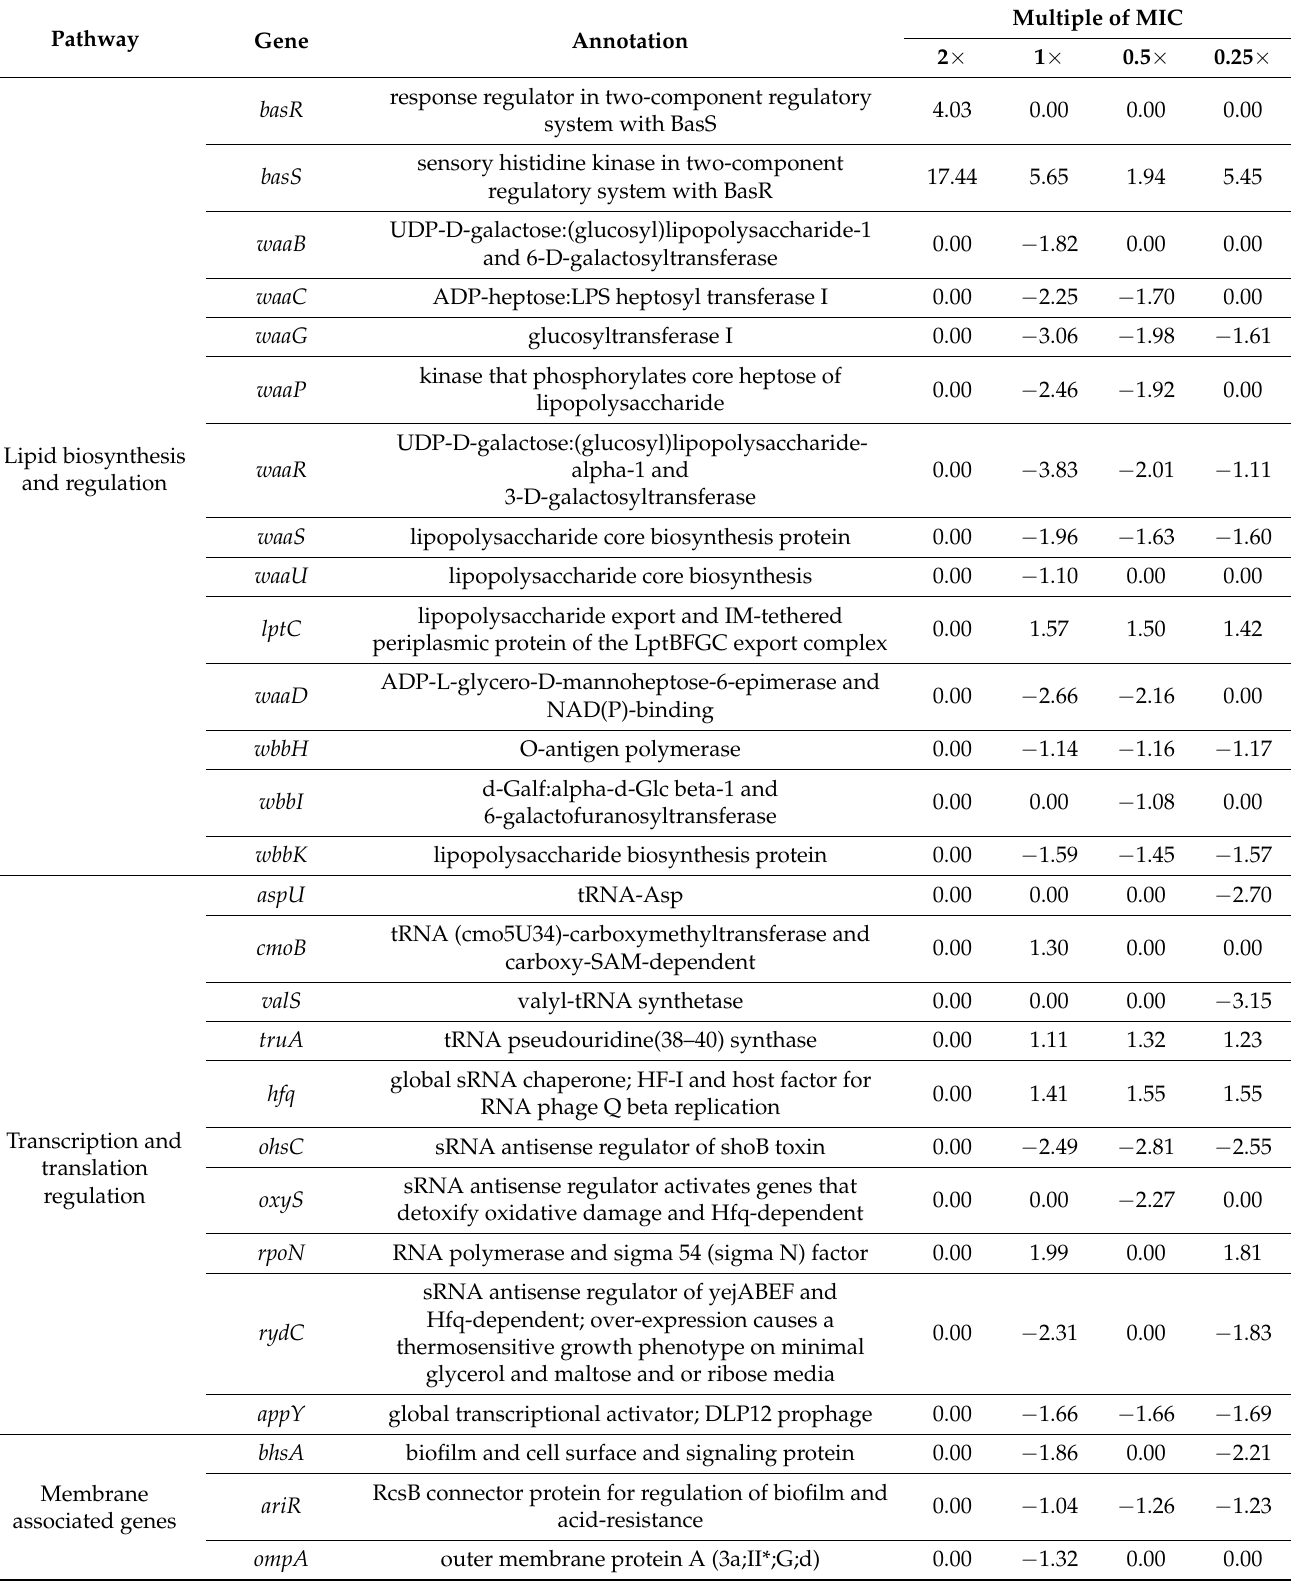
Table 1. Pathways and genes with significant differences in transposon insertions after colistin exposure. Values indicate